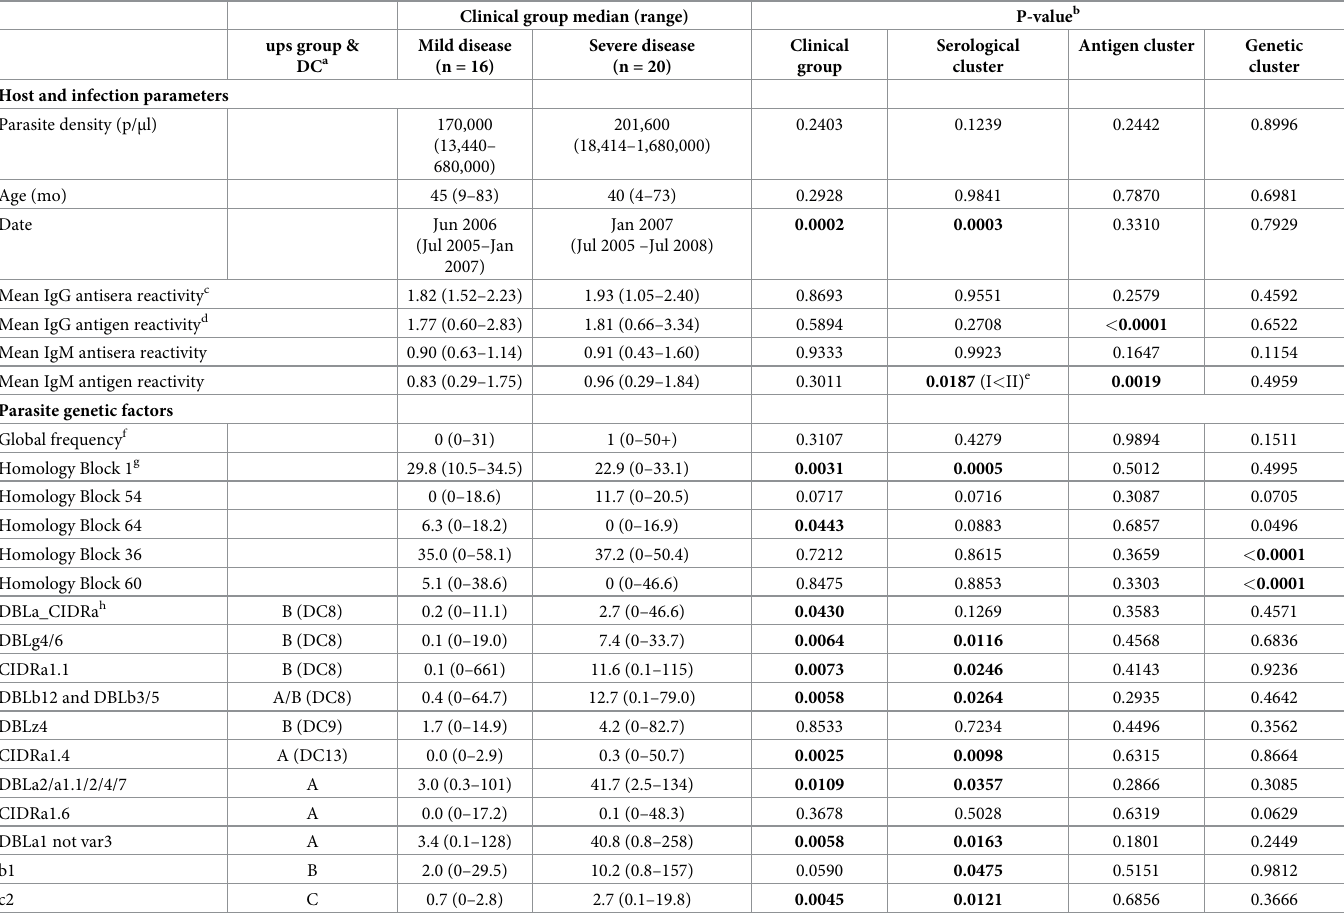
Table 1. Associations between clinical parameters, serological responses, parasite genetic factors and clusters found in serological and genetic diversity